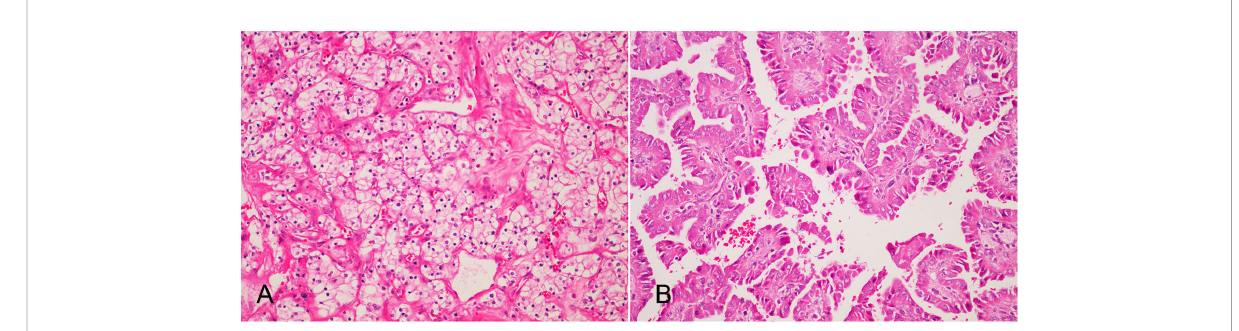
FIGURE 2 Postoperative pathology (HE×200): (A) The tumor in the left native kidney is clear cell renal cell carcinoma. The cancer cells are transparent and arranged in empty nests, and thin-walled sinusoidal vessels form a reticular septum; (B) The tumor in the left native kidney is type I papillary renal cell carcinoma of the right native kidney. Papillary structures formed by fi brovascular axis with foamy